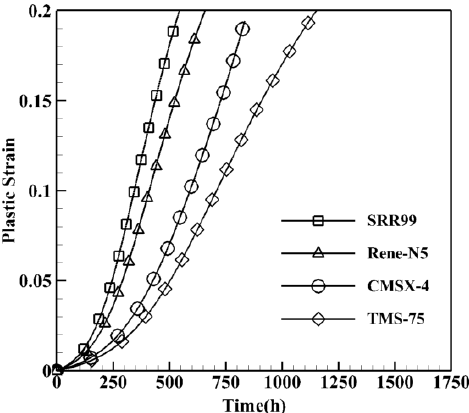
Figure 5. Creep curves obtained by arithmetic method in achieving the effective diffusion coefficient, ( D α ef f 0